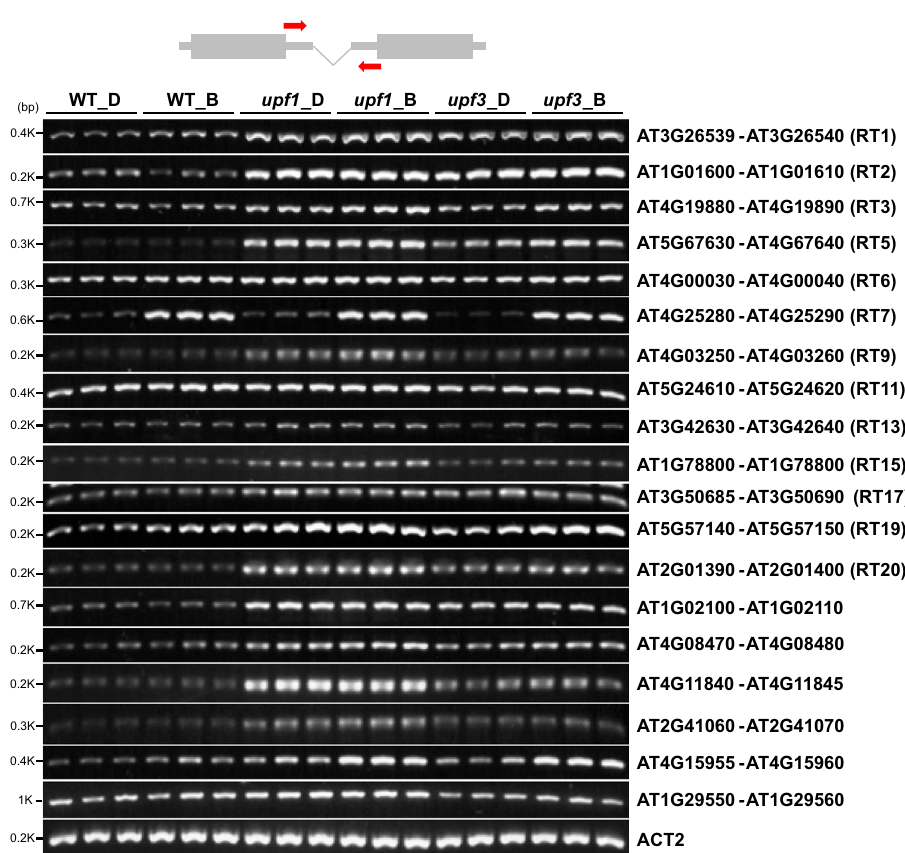
Fig. 2 Accumulation of bicistronic RTs in the NMD-de fi cient mutants, upf1-1 and upf3-1 . Results of semi-quantitative RT-PCR for 19 selected bicistronic RTs using primers (upper panel) that amplify the joint region between the fi rst and second genes are shown. ACT2 was used as an internal control. n = 3 biologically independent samples. D = Dark, B =